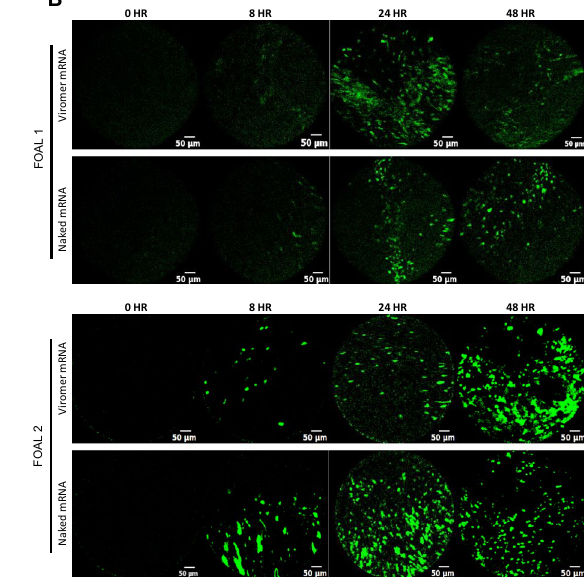
Figure 3. Aerosolized delivery of mRNA using either naked mRNA or mRNA with Viromer as a transfection agent results in green fluorescence of the guttural pouch epithelium detectable by transendoscopic fiberoptic confocal fluorescent microscopic (FCFM) imaging. (A) Schematic representation of the experiment. Endoscopic images (top row) and FCFM images (bottom row) were acquired by FCFM imaging immediately prior to transfection of the guttural pouch epithelium, and then at 8, 24, and 48 h post-transfection. Transfection was performed in each of 2 foals using 250 µg eGFP mRNA, delivered either as naked mRNA or Viromer mRNA. In the top row, the FCFM detection probe is visible as a bright horizontal line emitting light at the end in contact with the guttural pouch mucosa. In the bottom row, the second image from the left is an anatomical schematic to demonstrate the location of transendoscopic transfection and FCFM imaging. (B) Representative images from FCFM demonstrating minimal autofluorescence at baseline and eGFP expression at all post-transfection time-points (8, 24 and 48 h). FCFM was performed using excitation in the 488 nm channel. Please note that there was no apparent difference during real-time imaging between fluorescence in the pouches aerosolized with naked mRNA and those aerosolized with Viromer